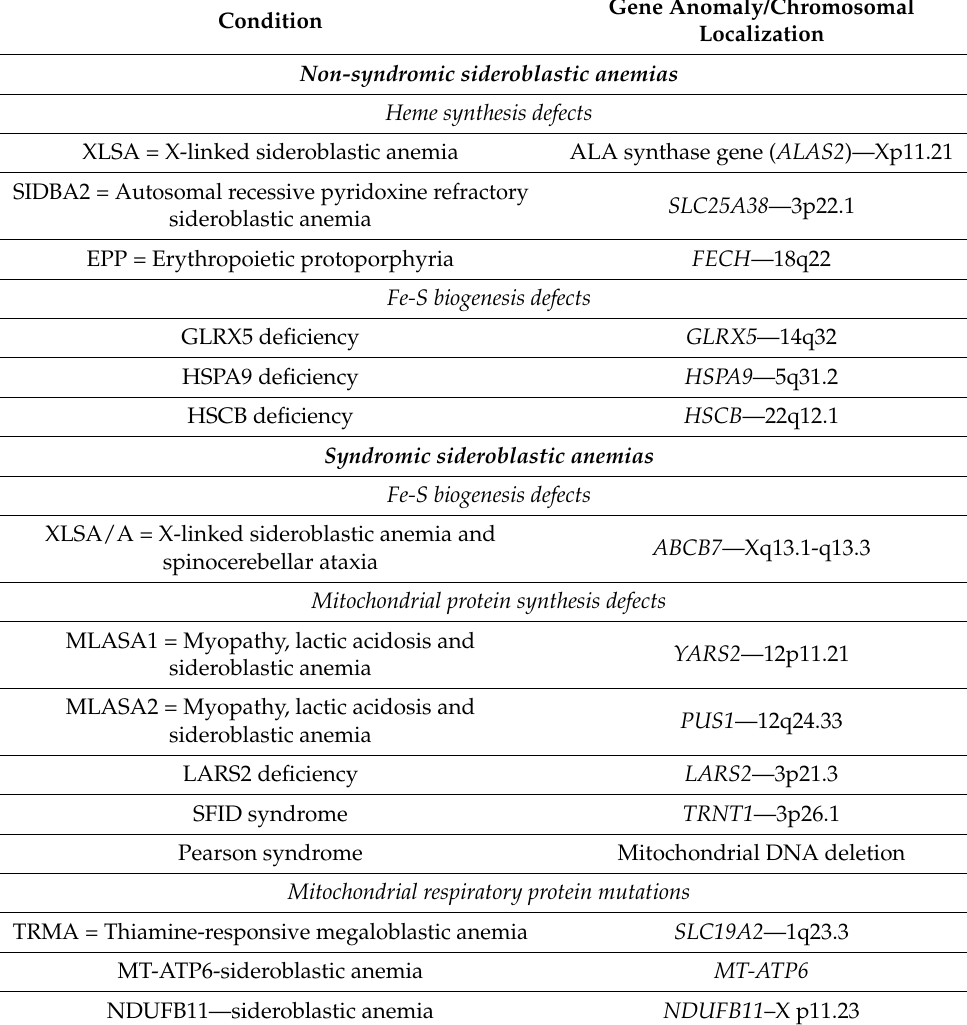
Table 2. Classification of congenital sideroblastic anemias. Gene Anomaly/Chromosomal Condition Localization Non-syndromic sideroblastic anemias Heme synthesis defects XLSA = X-linked sideroblastic